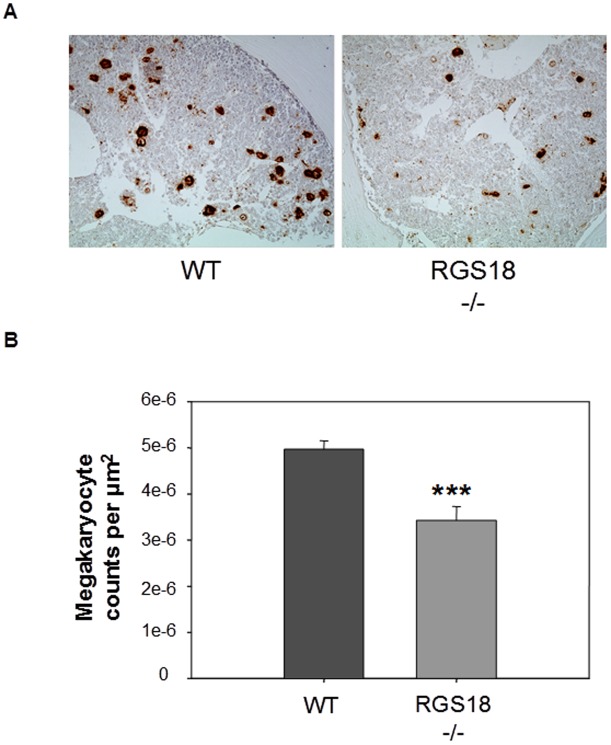
Bone marrow MKs in RGS18-/- mice.(A) Representative vWF immunostaining images of frozen femur sections from 9-week-old WT and RGS18-/- mice. Positively stained MKs from 6 bone marrow sections per mice (n = 3 per group) were scored under a microscope. Images were obtained using ECLIPSE E800 microscope (Nikon, Tokyo, Japan) equipped with a 4x objective (Nikon Eclipse E800). The number of positive vWF MKs was counted by using the 20x objective. Morpho Expert software (Explora Nova, La Rochelle, France) was used to acquire and process images. (B) Cumulative analysis of the numbers of MKs per square millimeter is shown. ***P<.001.